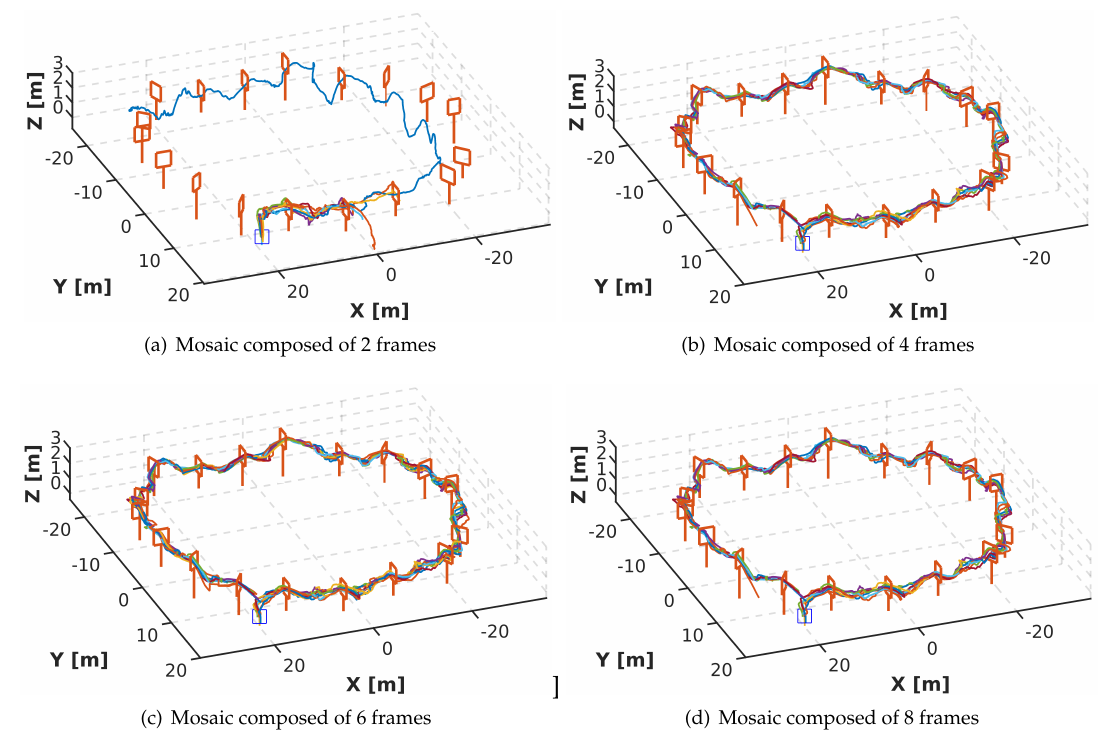
Figure 21. Side view of the 10 runs shown in Figure 20. Note that using mosaic images of 2 or 4 frames are unstable and do not allow for the drone to finish the